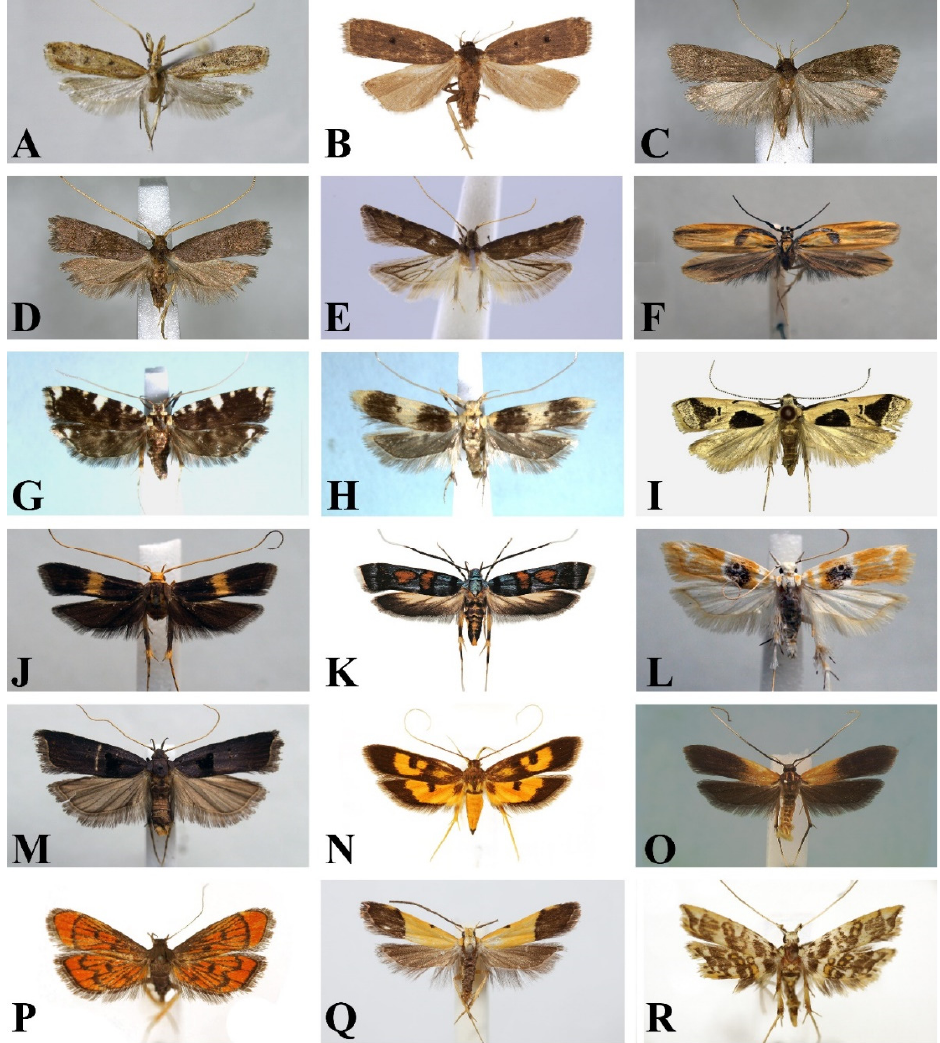
Figure 1. Adults of representative species of the family Lecithoceridae: ( A ) Frisilia triturata Meyrick; ( B ) Lecithocera distigmatella (Zeller); ( C ) Homaloxestis cholopis Meyrick; ( D ) Lecithocera aulias Meyrick; ( E ) Lecithocera pakiaensis Park; ( F ) Tisis sabahensis Park; ( G ) Torodora karismata Park; ( H ) Caveana diemski Park; ( I ) Deltoplastis gyroflexa Park and Wang; ( J ) Thubana stenosis Park; ( K ) Tiriza leucotella Walker; ( L ) Torodora epicharis Park; ( M ) Torodora fuscobasalis Park; ( N ) Pacificulla esdiparki Park; ( O ) Lamprista emmeli Park; ( P ) Gonaepa pyrchorda Meyrick; ( Q ) Crocanthes micradelpha (Lower); ( R ) Crocanthes pancala (Turner).